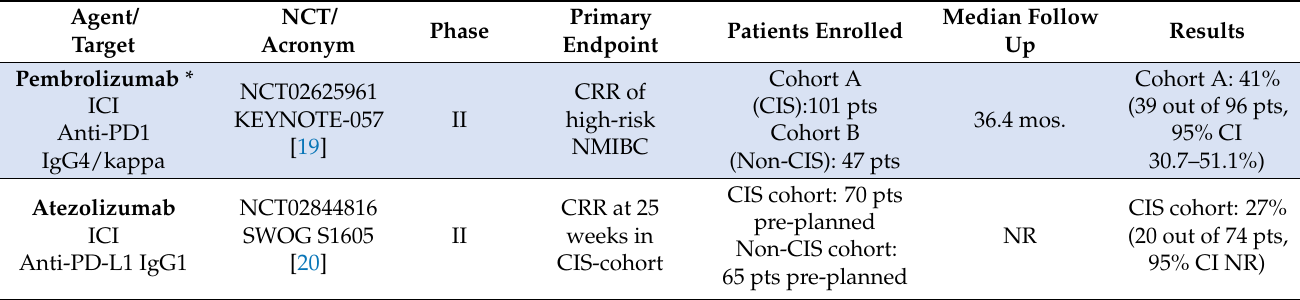
Table 1. Key positive clinical trials enrolling patients with BCG-unresponsive